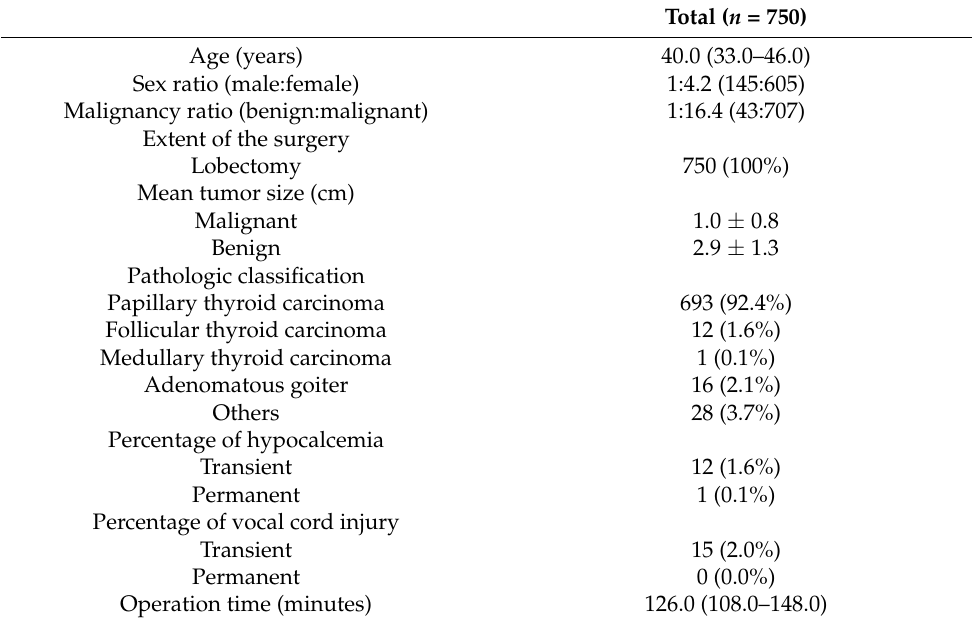
Table 1. Clinicopathologic characteristics of the cohort.